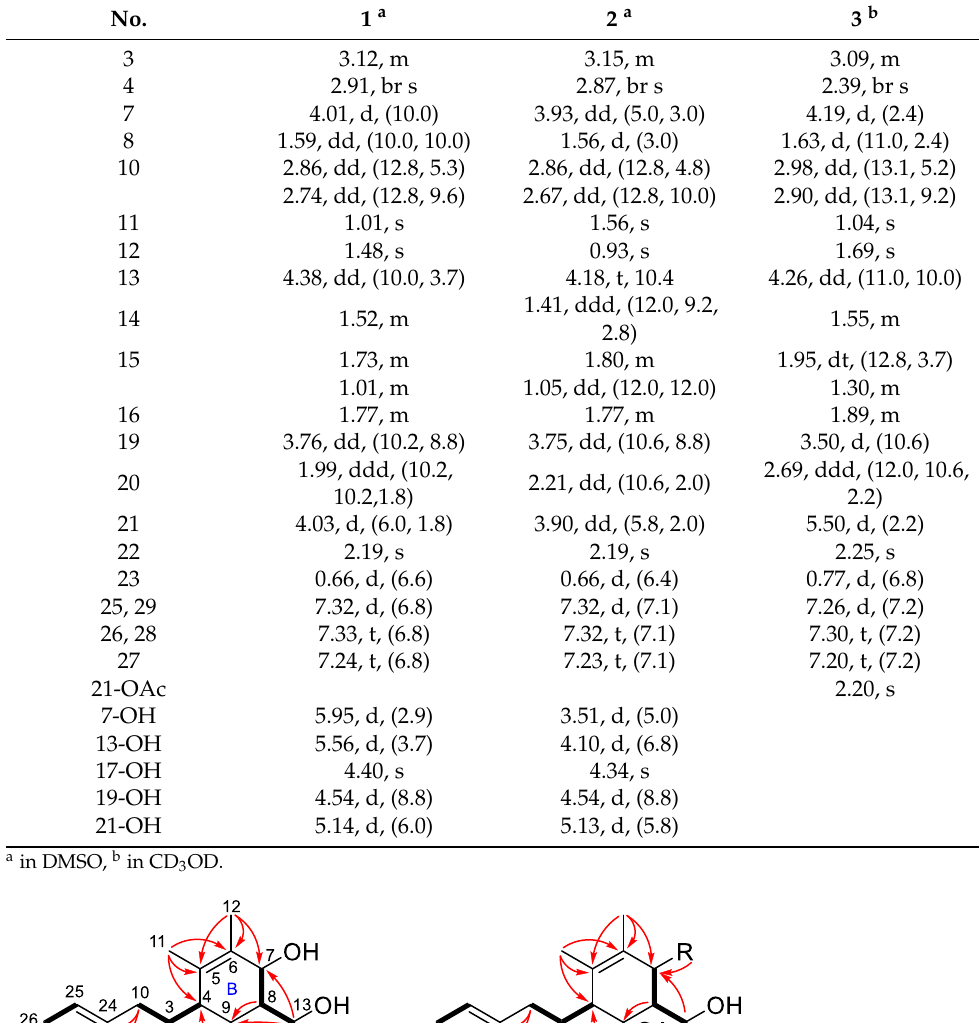
Table 2. The 1 H NMR data (600 MHz) of compounds 1 – 3 ( δ in ppm, J in Hz).